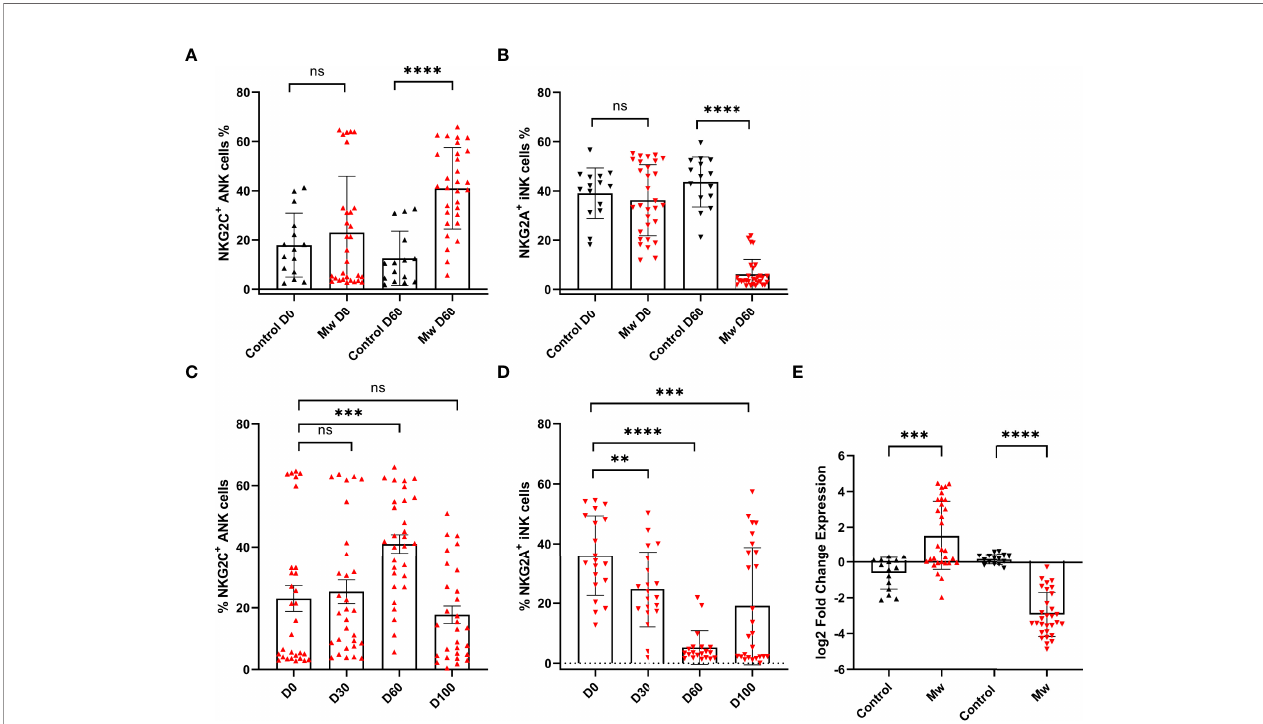
FIGURE 3 | Impact of Mw on both ANK cells and iNK) cells: (A) Scatter dot with bar plot showing the expression of NKG2C + ANK cells (Mw group -n=30 and control group- n=15) and (B) NKG2A + iNK cells (Mw group-n=30 and control group- n=15) with and without of Mw vaccine at baseline and day 60. (C) Scatter dot with bar plot showing kinetics of NKG2C + ANK cells, and (D) NKG2A + iNK cells expression in Mw group (n=30) at baseline, day 30, day 60, and day 100. (E) log2FC expression of NKG2C + and NKG2A + in both Mw group (n=30) and vontrol group (n=15) at day 60 after normalization with baseline. Red upside and downside shaded triangles represent NKG2C + ANK and NKG2A + iNK, respectively, for Mw group. Black upside and downside shaded triangles represent NKG2C + ANK and NKG2A + iNK, respectively, for control group. ****p < 0.0001, **p <0.01, ***p <0.001, and ns, p-value not signi fi